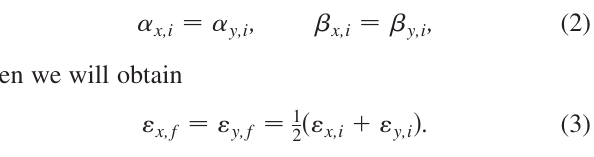
FIG. 2. Schematic for a rotator matched with a gantry (cour- tesy PIMMS [3]), where the rotation angle of the rotator is half the gantry rotation angle to keep the betatron matching un- changed when the gantry is